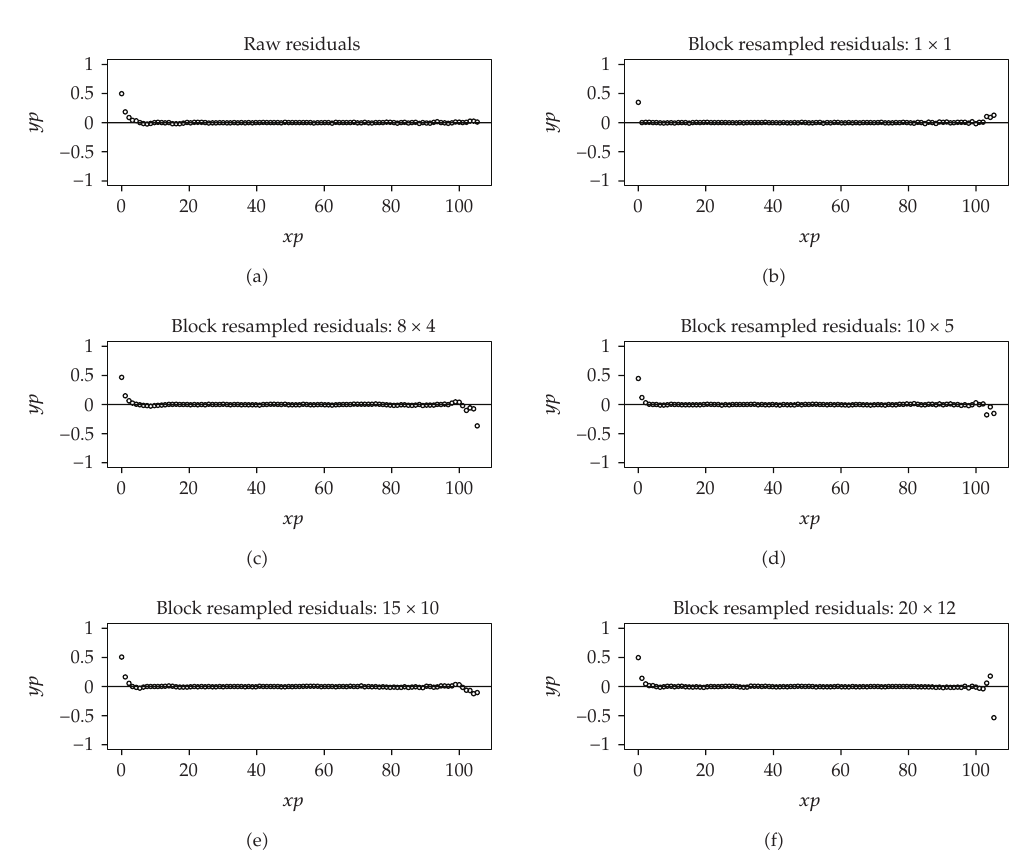
Figure 5: Correlograms for resampled deviance residuals based on di ff erent block sizes.